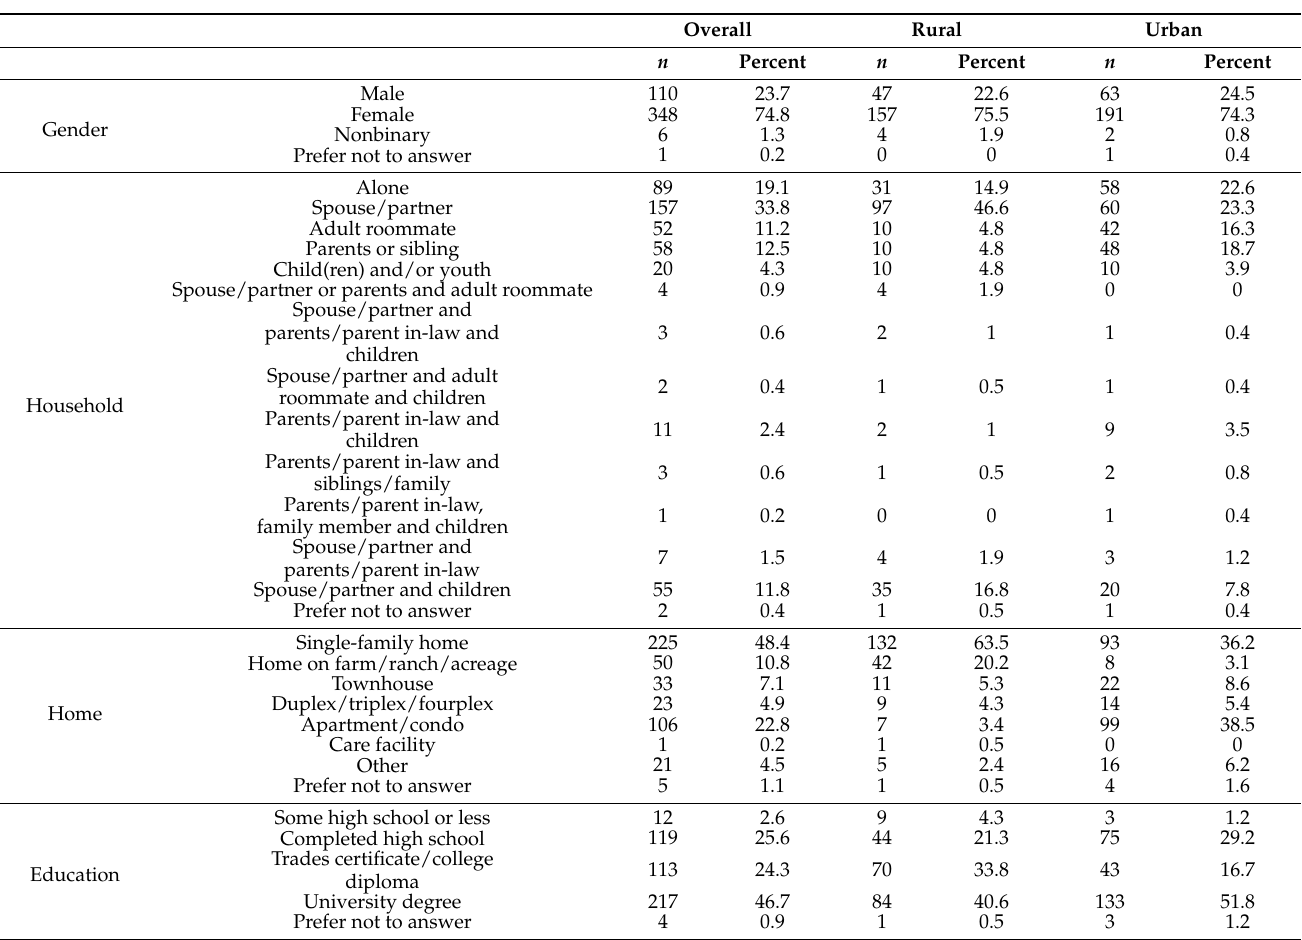
Table A2. Participants’ Socio-Demographic Information: Gender, Household Arrangement, House Type, Education, Occupation, Workplace Setting, and